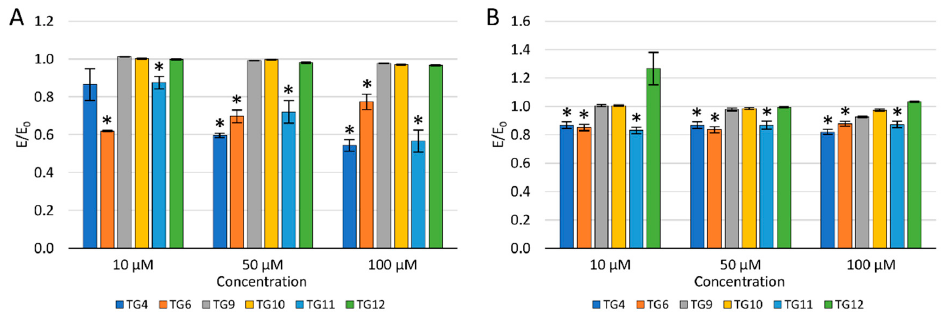
Figure 4. The effect of the tested compounds on the level of reactive oxygen species ( A ) and nitric oxide ( B ) in TC28a2 cells; * p < 0.05—significant difference compared to the control.